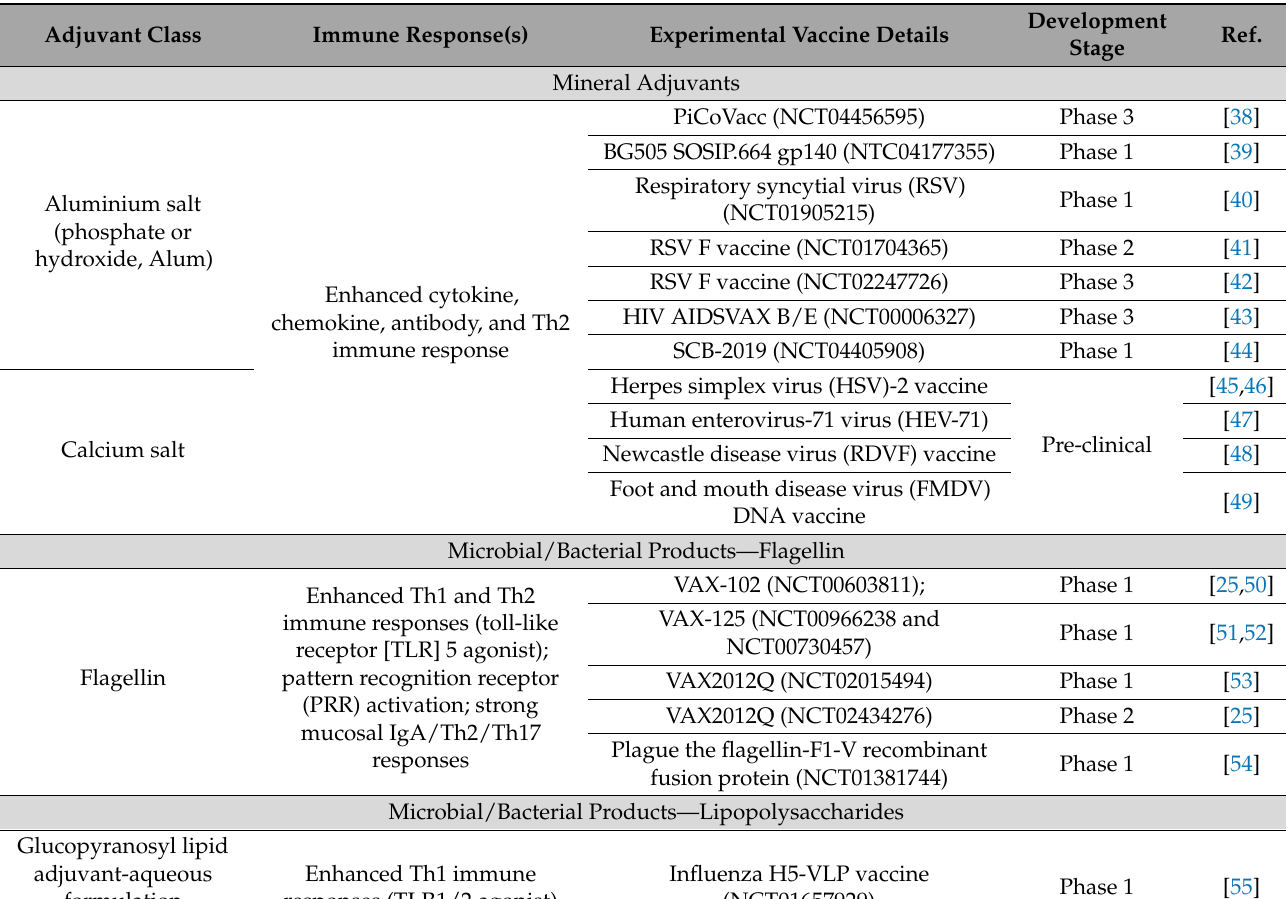
Table 2. Vaccine adjuvants used in pre-clinical and clinical development against infectious dis- ease